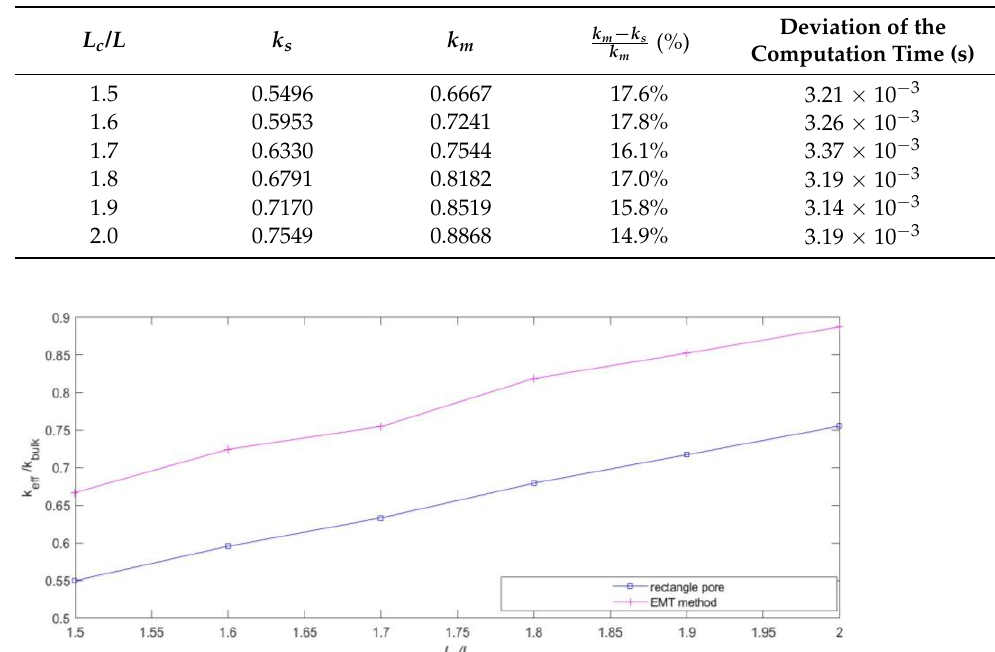
Figure 6. The effective thermal conductivity with the EMT method and the MCBU method with the changes of